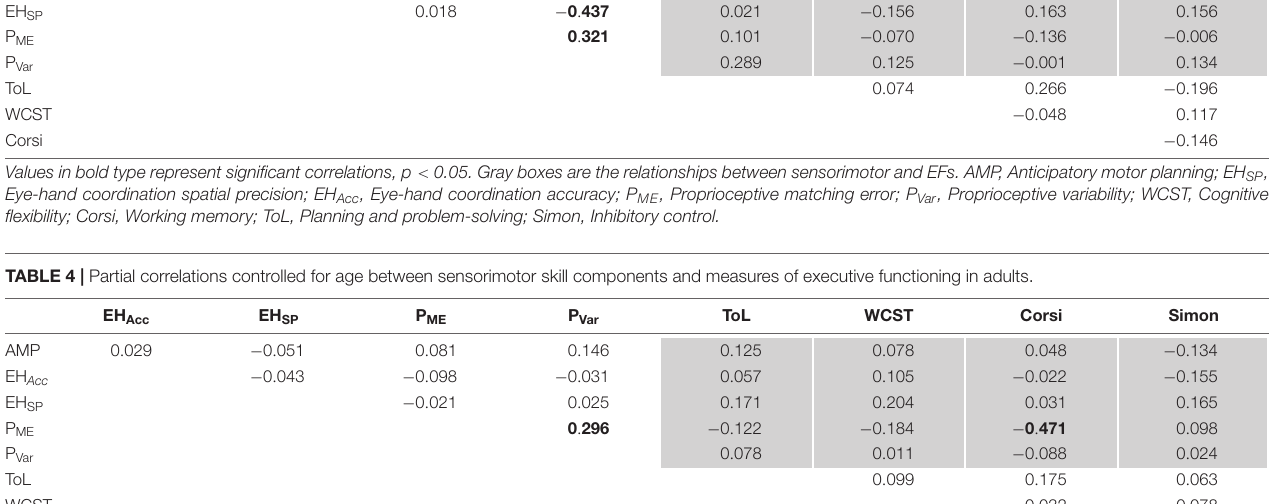
Values in bold type represent significant correlations, p < 0.05. Gray boxes are the relationships between sensorimotor and EFs. AMP, Anticipatory motor planning; EH SP , Eye-hand coordination spatial precision; EH Acc , Eye-hand coordination accuracy; P ME , Proprioceptive matching error; P Var , Proprioceptive variability; WCST, Cognitive flexibility; Corsi, Working memory; ToL, Planning and problem-solving; Simon, Inhibitory